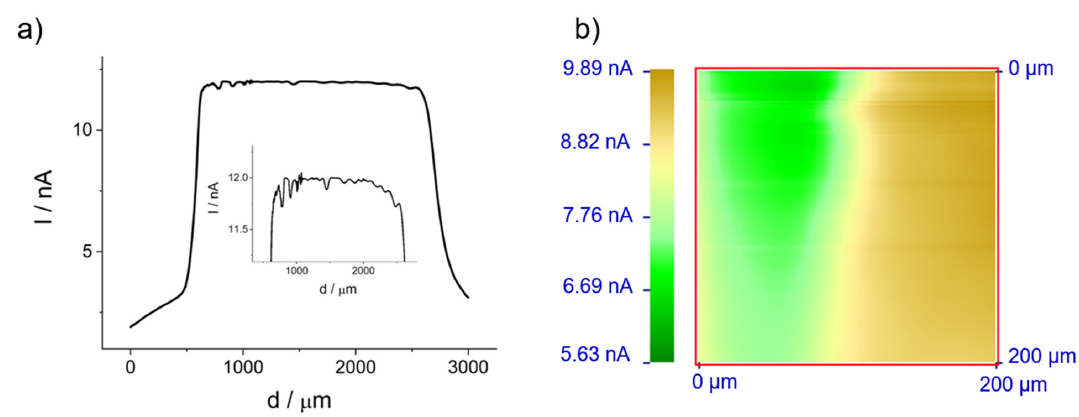
Figure 4. One-dimensional ( a ) and bi-dimensional ( b ) scans obtained by using Fc as redox mediator and a Pt microdisk with 12.5 µm radius. The tip was positioned at 10 µm above the substrate. Series of SECM measurements, as those described above, were performed using the oligo-( S )- BT 2 T 4 -Au substrate in feedback and competition mode; in the latter case, the applied potentials at both SECM tip and substrate were such that the same process of the redox mediator (oxidation or